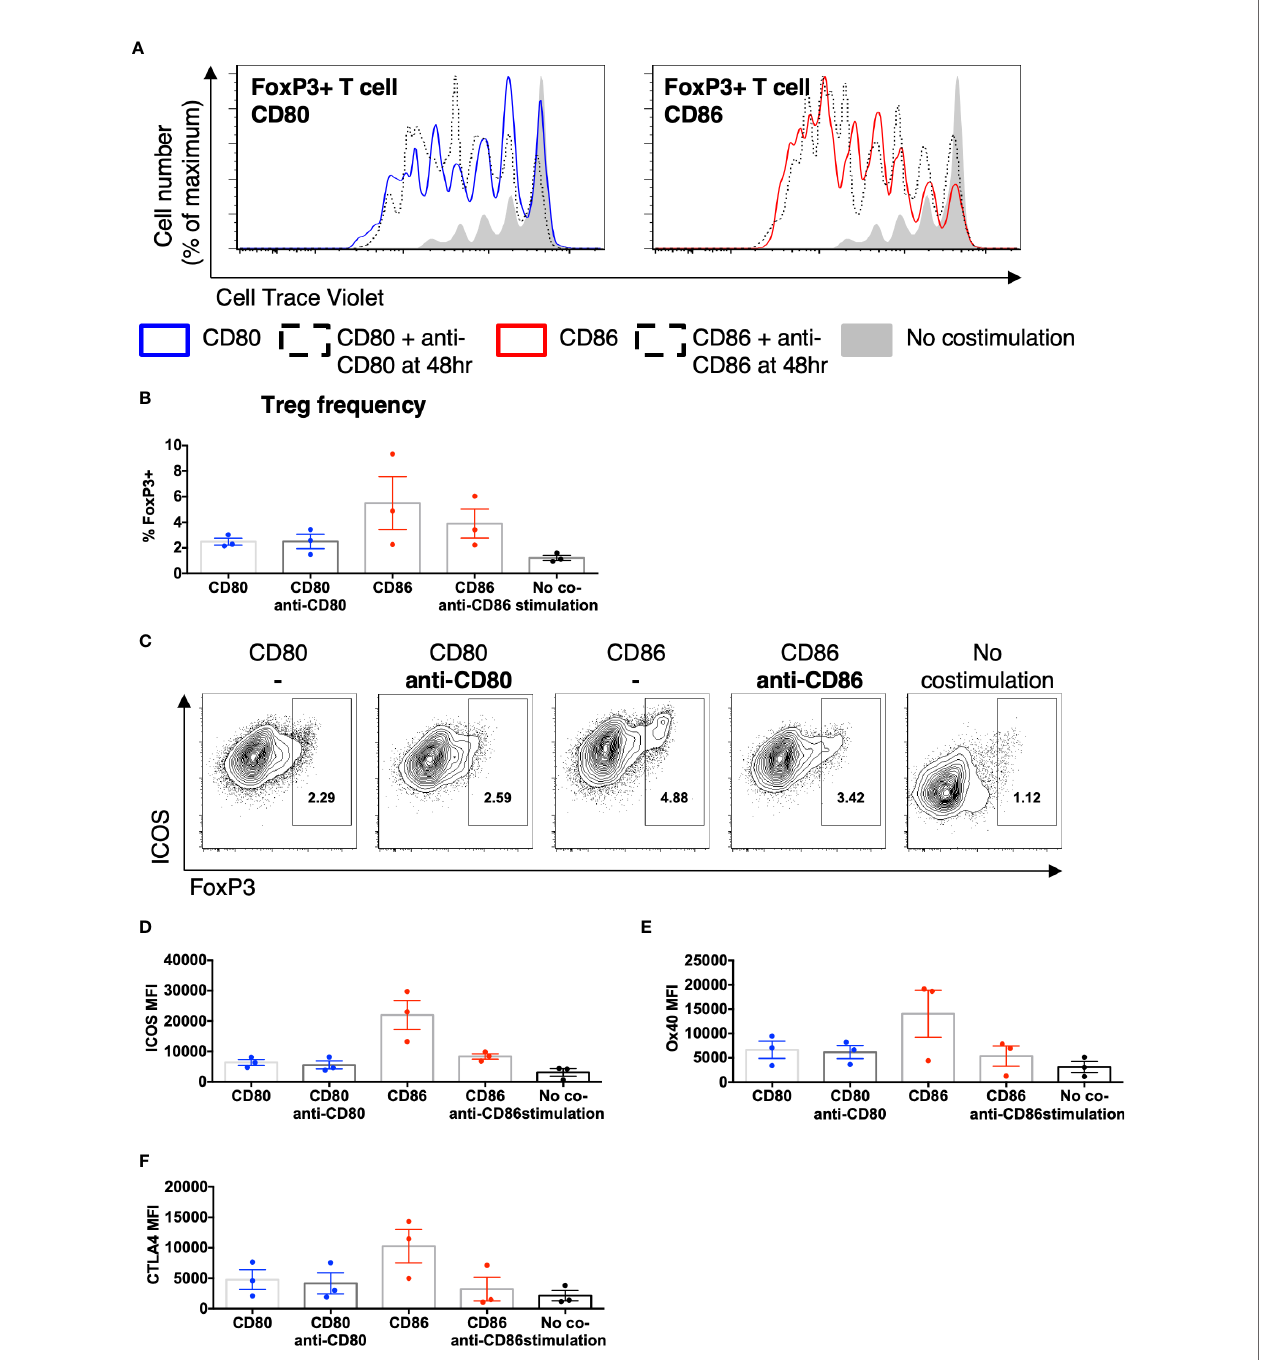
FIGURE 5 | Treg phenotype is dependent upon persistent CD86 costimulation. CTV labelled total memory CD4 T cells isolated from healthy donors were cultured for 5 days with CHO-CD80, CHO-CD-86, or untransduced CHO (no costimulation), at a ratio of 10 T cells to one CHO cell, with 0.5 m g/ml anti-human-CD3 and the addition of anti-CD80 or anti-CD86 48 h. (A) representative proliferation traces of FoxP3+ T cells following blockade of CD80 or CD86 after 48 h of stimulation. (B) frequency of FoxP3+ amongst divided CD4 T cells following addition of anti-CD80 or anti-CD86 antibodies after 48 h of culture. (C) representative fl ow cytometry plots of showing ICOS expression after 5 days in divided CD4 T cells following the addition of anti-CD80 or anti-CD86 antibodies after 48 h of culture. Aggregate data for the expression of (D) ICOS, (E) OX40, (F) CTLA4 in divided CD4+FoxP3+ve T cells. Three independent